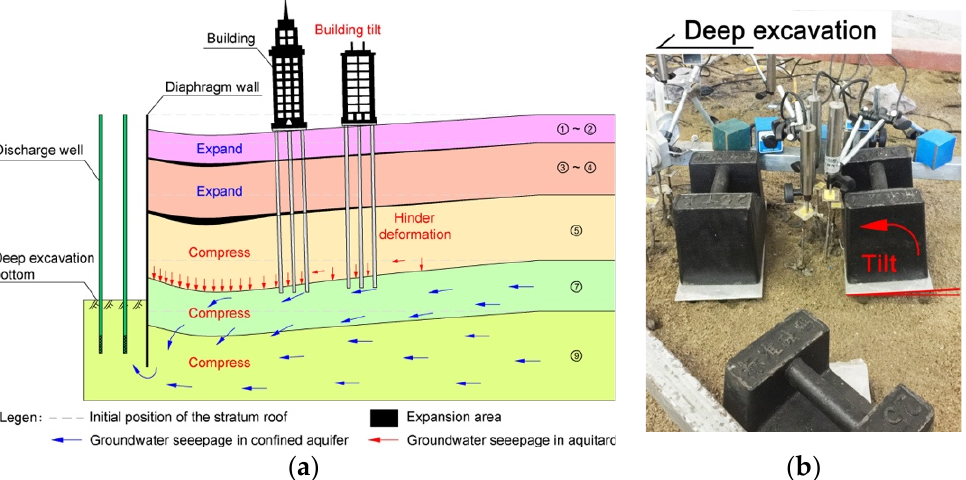
Figure 10. Stratified settlement in strata around buildings: ( a ) Conceptual schema; ( b ) Buildings’ tilt in physical model.